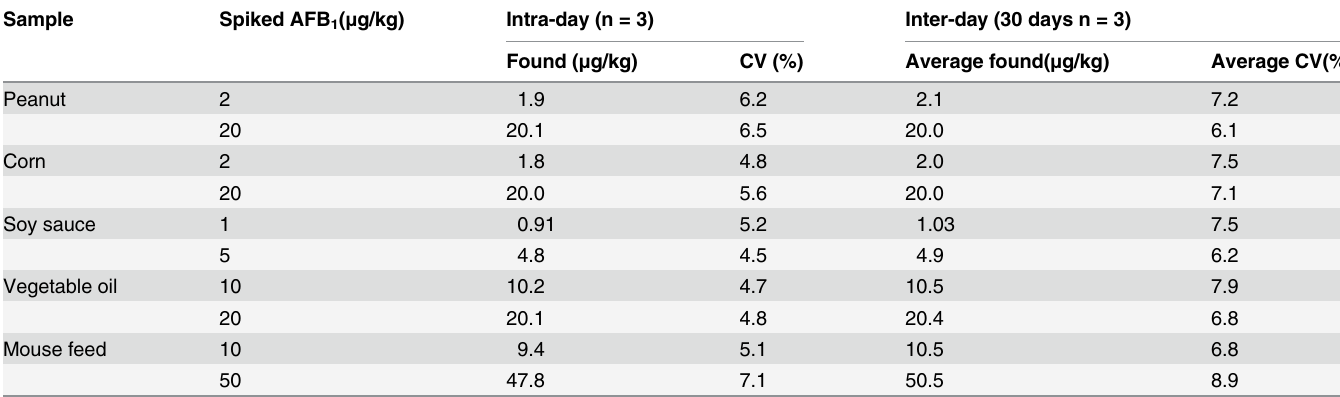
Table 4. Intra- and inter-day CV tests of CTRFIA sensing.